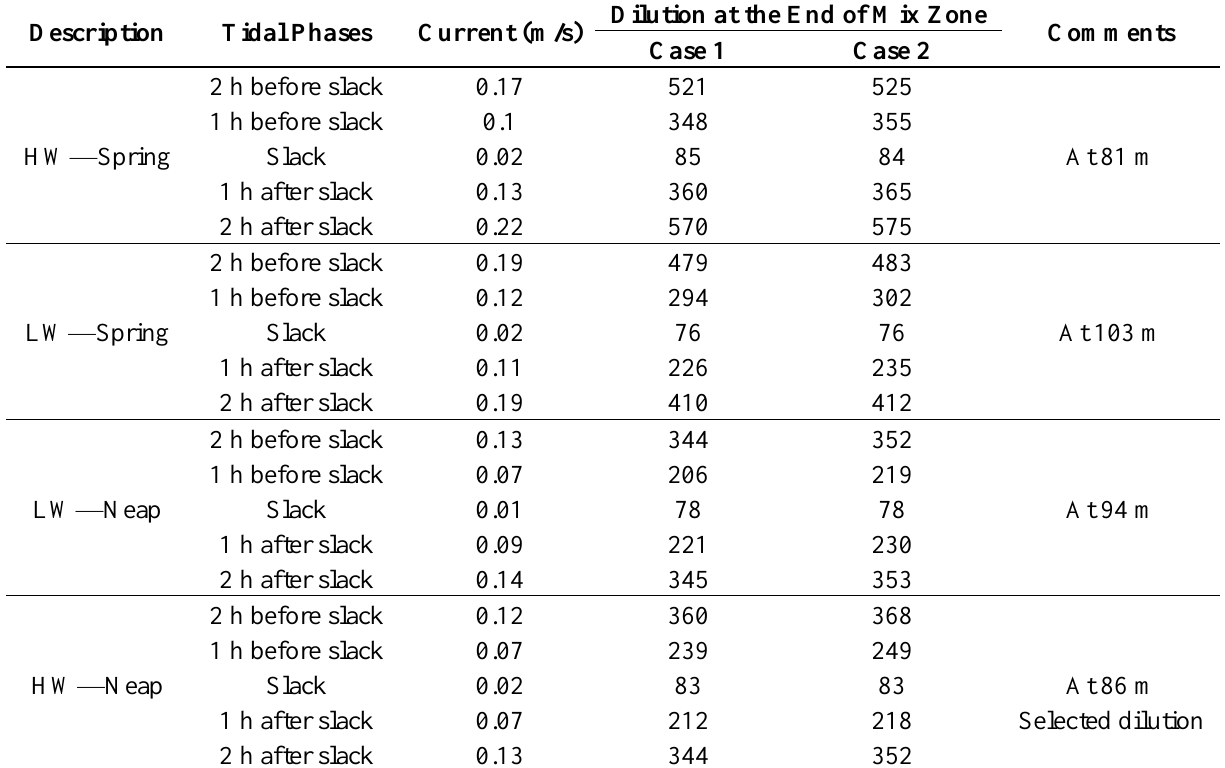
Table 2. Results of dilution